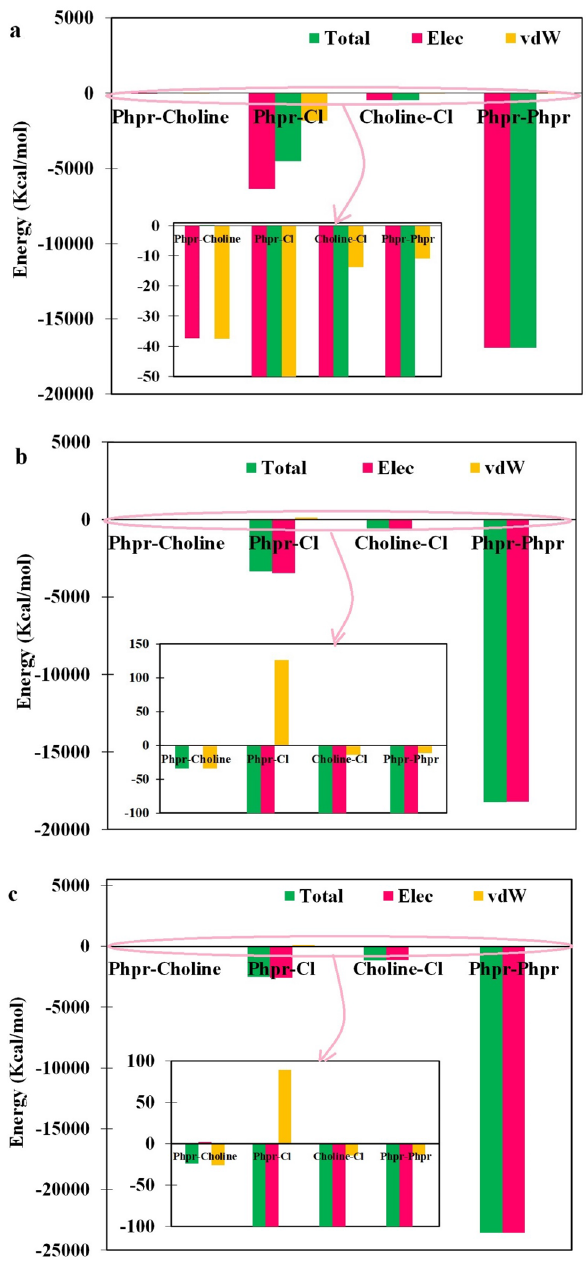
Figure 6. Interaction energies of Phpr-choline, Phpr–Cl − , choline–Cl − , Phpr–Phpr in DES were calculated using ‘NAMD energy’ plugins of the VMD package 40 at ( a ) 293 K, ( b ) 321 K and ( c ) 400